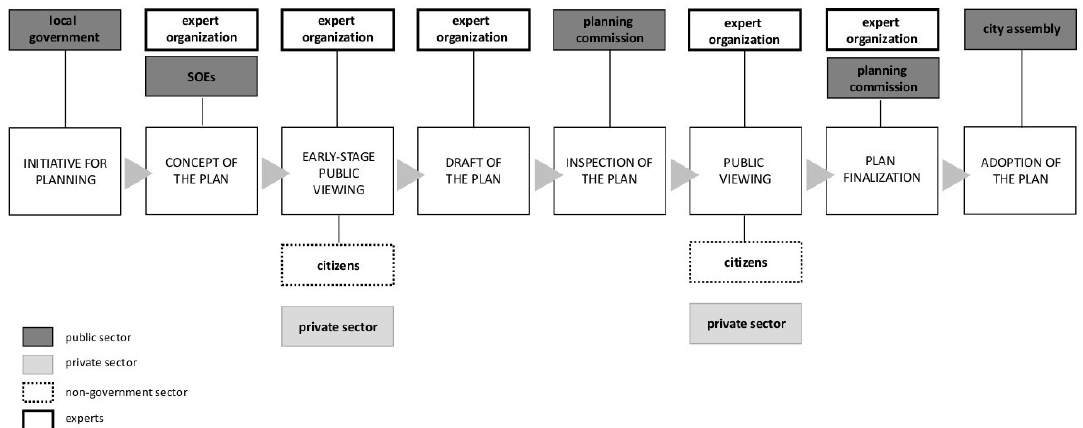
Figure 2. Formal and informal arrangements in the planning procedure (Source: Authors, based on [88]).